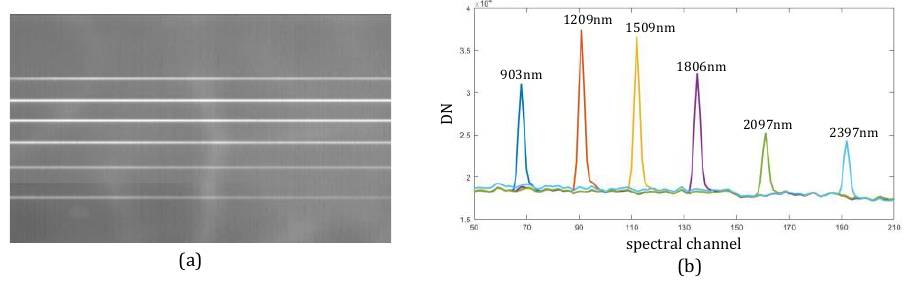
Figure 10. ( a ) Slit images corresponding to wavelengths of 903, 1209, 1509, 1806, 2097, and 2397 nm and ( b ) radiation intensities of different channels.